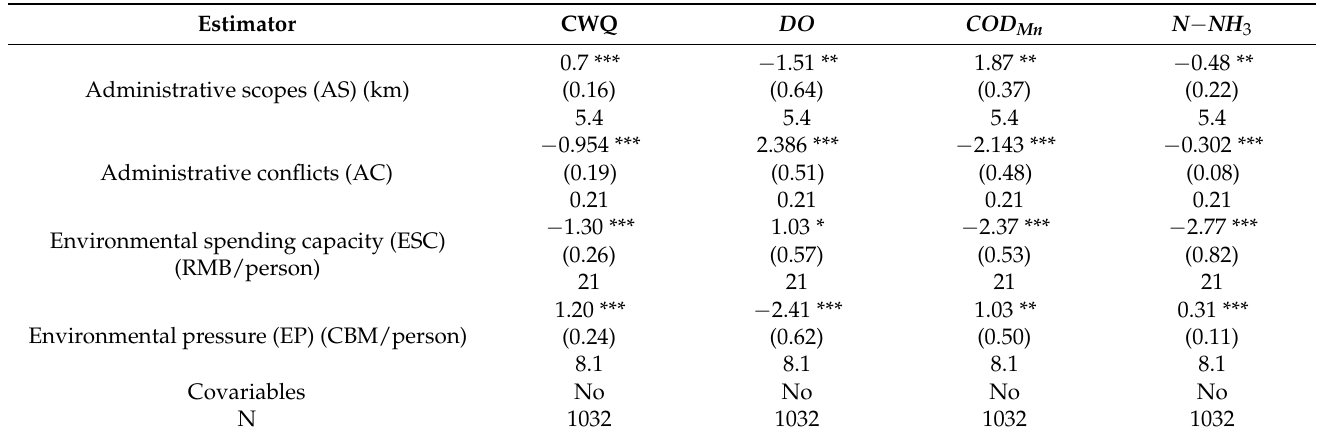
Table 5. Empirical results of factors influencing the effectiveness of